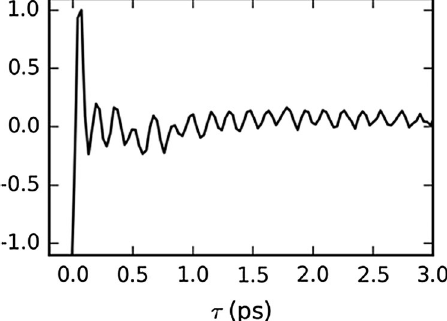
FIG. 3. Signal vs time delay for a single tile in Fig. 2. The tile chosen is the second row, fourth column.